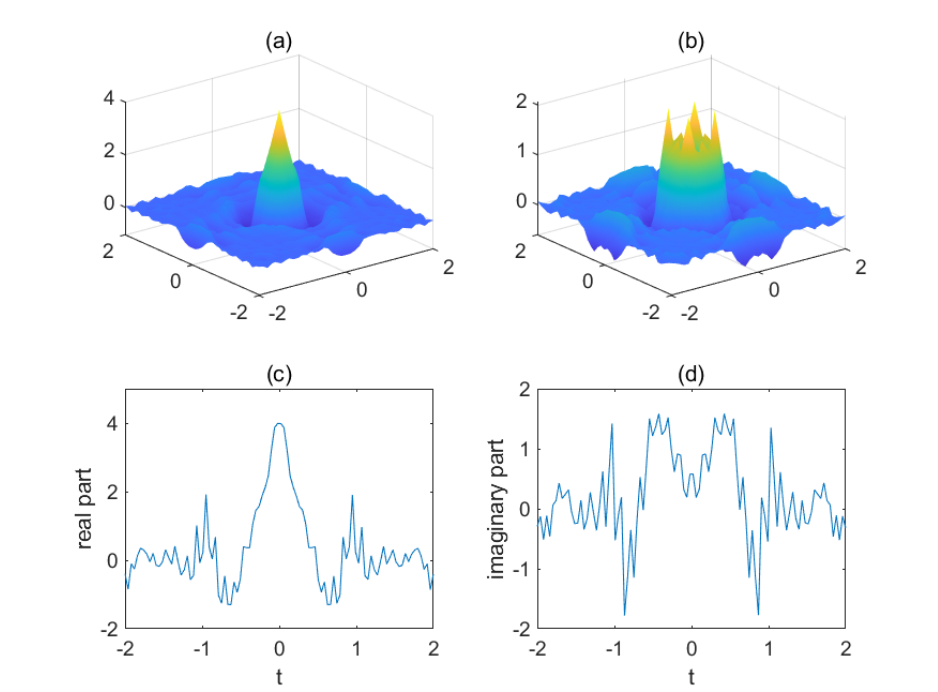
Figure 1. ( a ) Real part graph of g α ( x , y ) with α 1 = α 2 = π